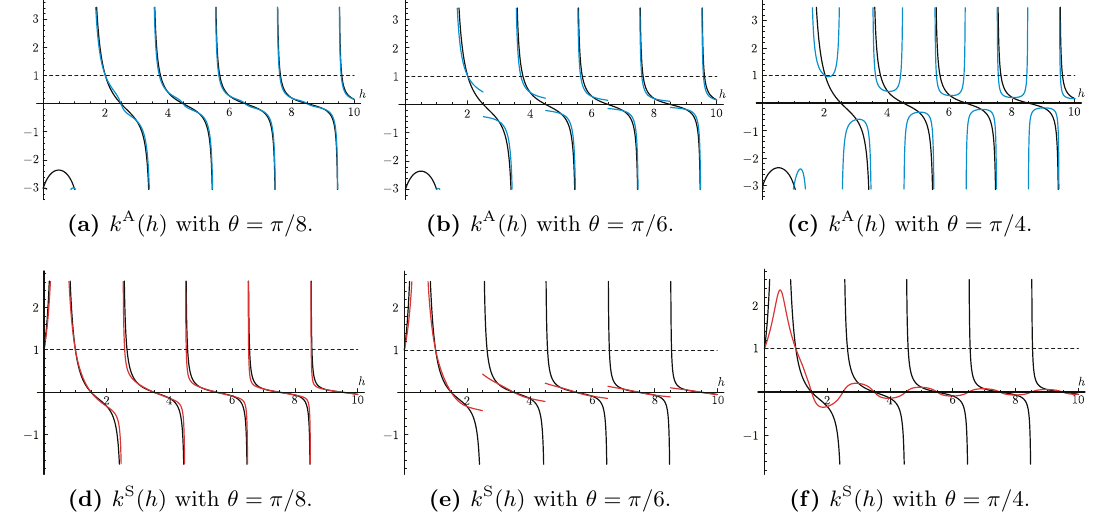
Figure 11. Plots of k A ( h ) and k S ( h ) for (cid:1) = 1 = 4 and (cid:18) = (cid:25)= 8, (cid:25)= 6 and (cid:25)= 4. Black lines are for reference, represent the value of k A = S ( h; (cid:18) ) for (cid:18) =